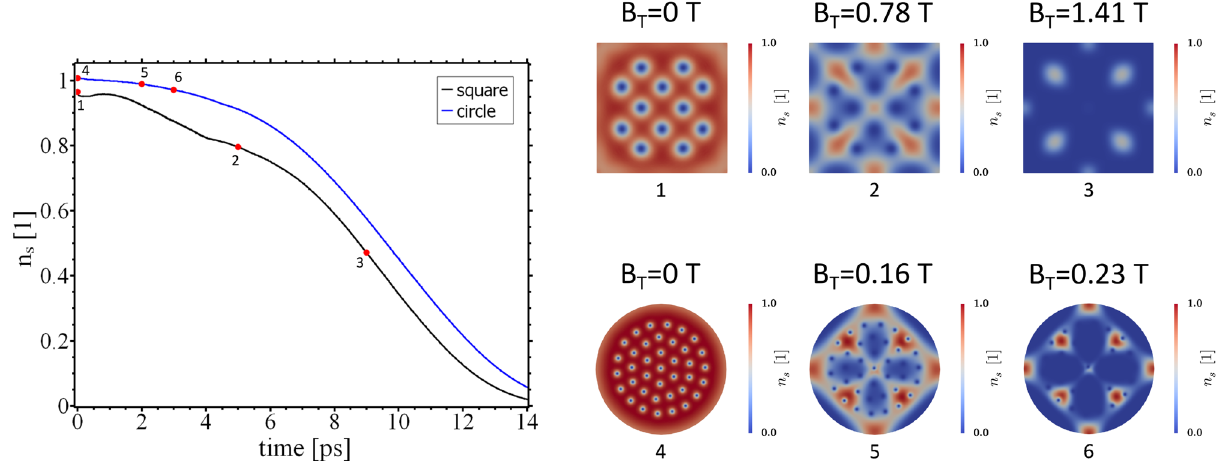
0.17 T and application of a STE-pulse with a 1.659 T µ m/ps. T = = 250 nm and the blue curve to a disc of radius =